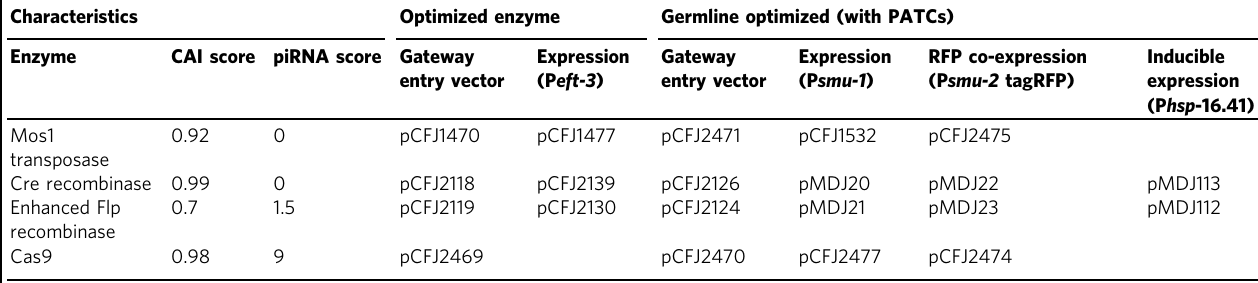
Table 3 Optimized gene-editing